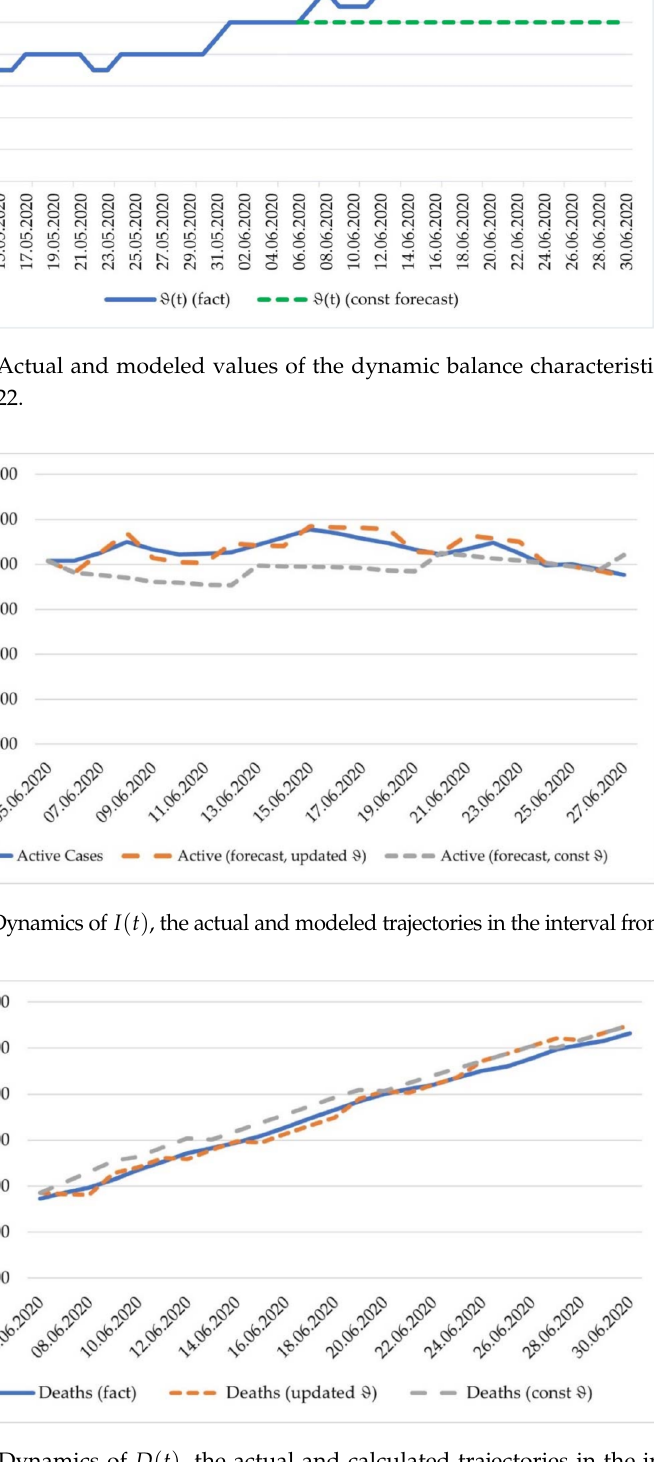
Figure 5. Dynamics of D ( t ) , the actual and calculated trajectories in the interval from 6 June